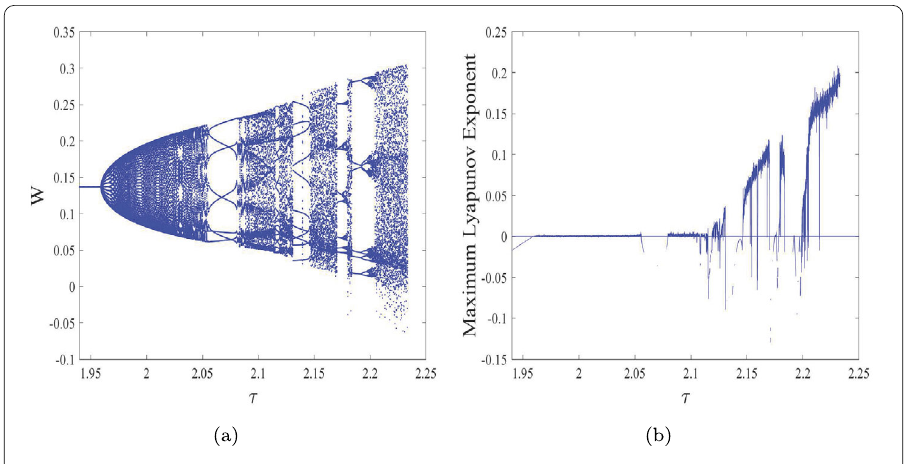
Figure 7 Diagram of Neimark–Sacker bifurcation and the corresponding maximum Lyapunov